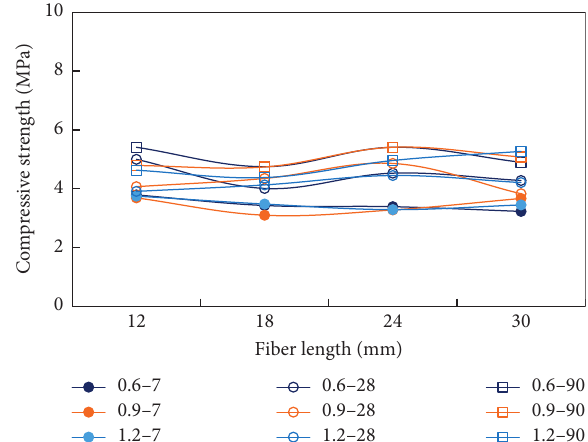
Figure 12: Trend chart of UCS of CSM with different fiber lengths.